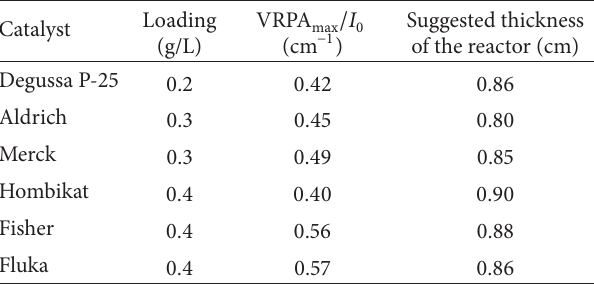
Table 3: Optimum catalyst loading, maximum energy absorbed, and design thickness of flat plate reactor under solar